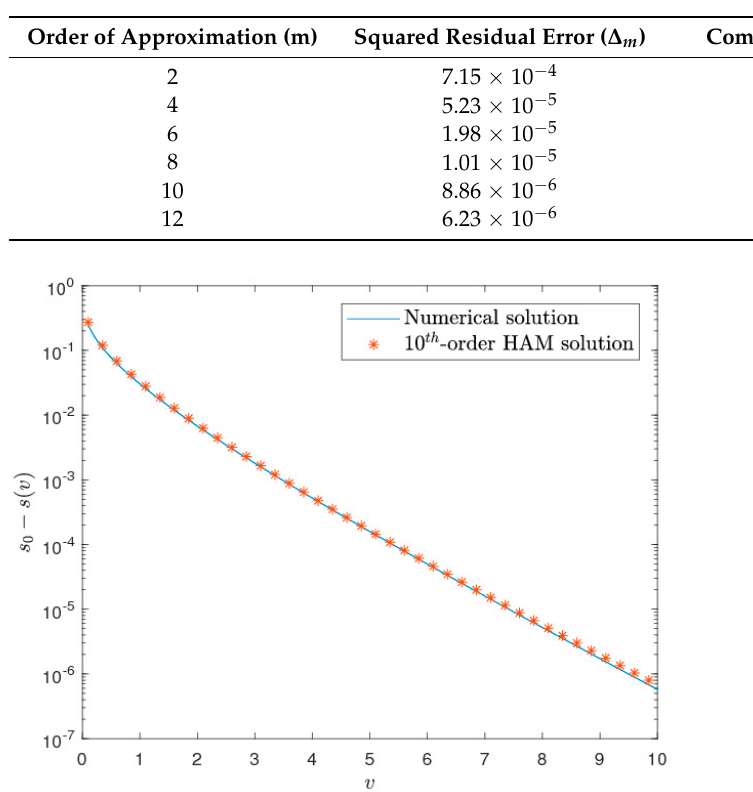
Figure 6. Comparison between the Theis solution and 10th-order HAM-based solution for the selected case.